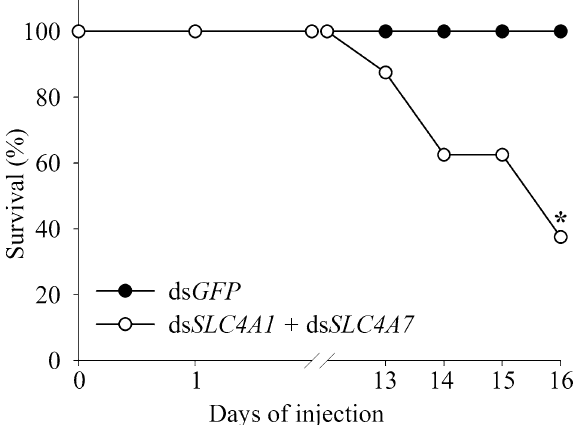
Figure 4. Effects of CqSLC4 silencing on survival during the molt cycle of C. quadricarinatus . Graph showing survival rates during pre-molt. The control group was injected with ds GFP (n = 8); the treatment groups were injected with ds SLC4A1 + ds SLC4A7 (n = 8). All groups were given ecdysone injections to induce molting. Asterisk indicates significant difference in